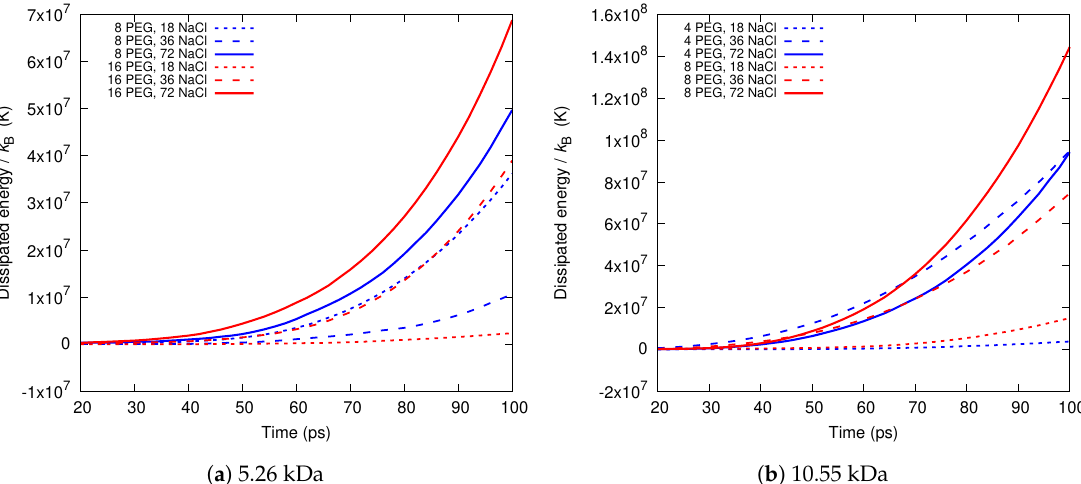
Figure 24. The energy dissipated from ions divided by the Boltzmann constant, k B , as a function of production time for samples with ( a ) 5.26-kDa and ( b ) 10.55-kDa PEG chains. Curves correspond to different numbers of PEG chains and NaCl ion pairs, see the legend. Plotted with gnuplot [56].